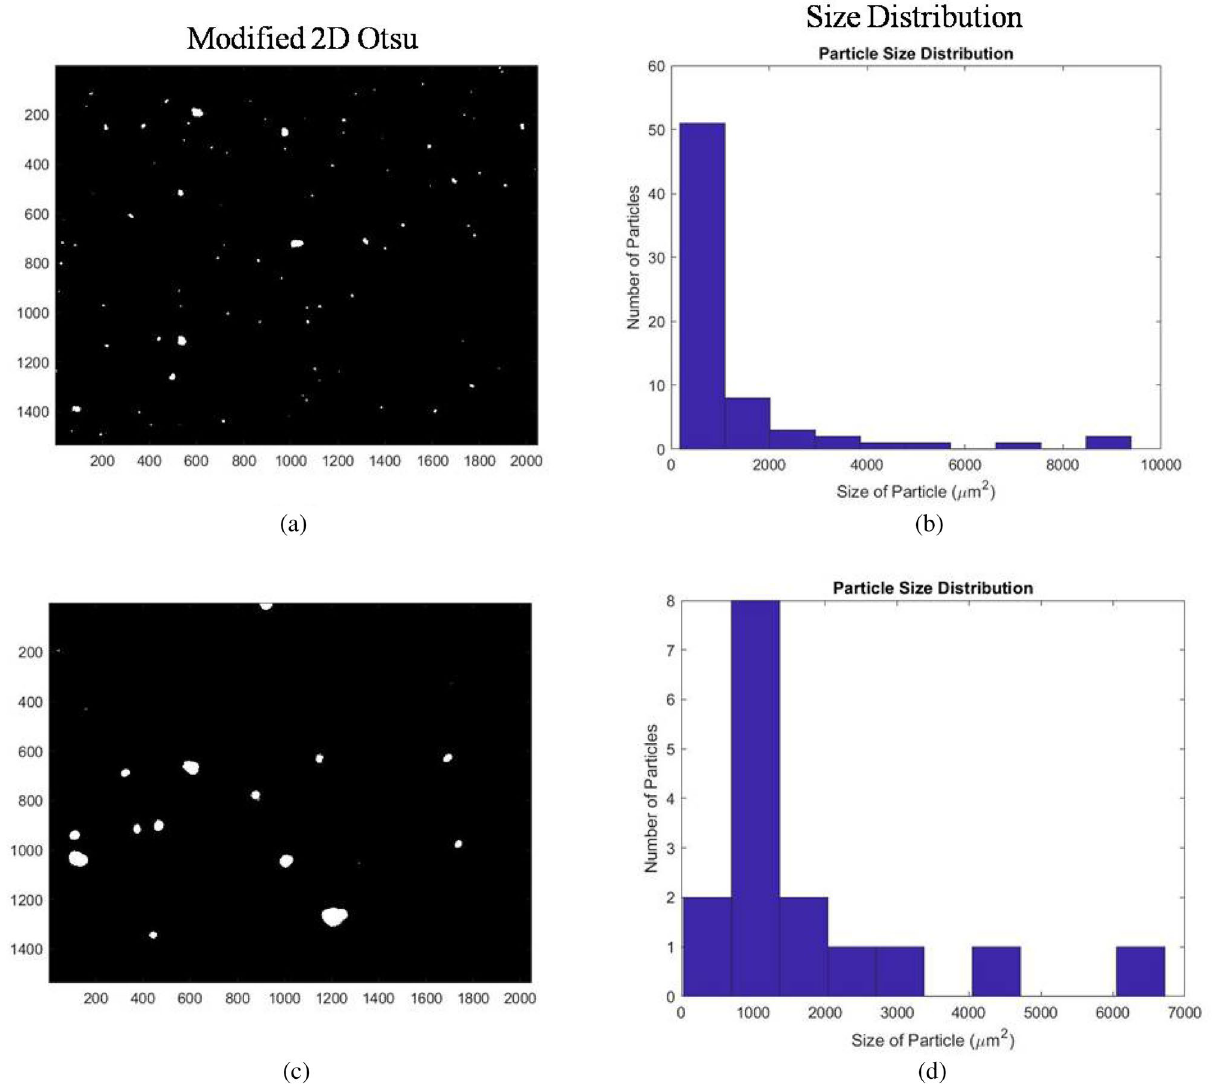
Figure 9. Output of modified 2D Otsu thresholding. ( a ) and ( b ) are the modified 2D Otsu thresholded output figure and size distribution graph for Fig. 4b, whereas ( c ) and ( d ) are the output figure and size distribution for Fig.